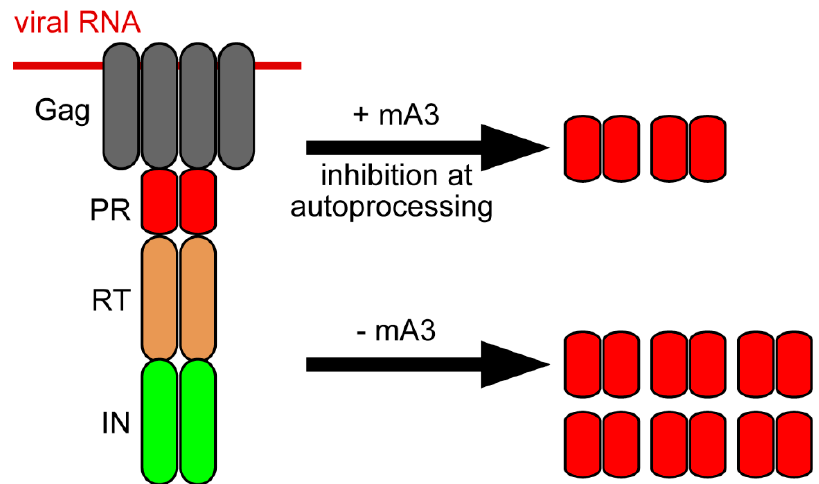
Figure 3. Effect of mA3 on Pr180gag-pol autoprocessing. In the presence of physiological amount of mA3, MuLV Pr180gag-pol autoprocessing is dysregulated, leading to a reduction in mature PR, and possibly RT and IN as well, in virions.